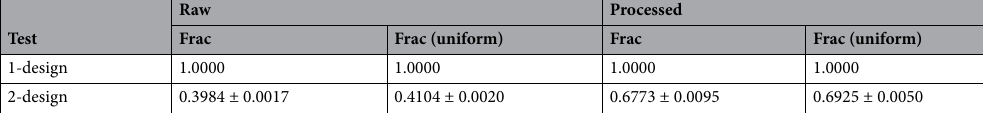
Table 8. Fraction of states for which the ensemble of unitaries generated using the ibmq_sydney quantum processor passed the different tests. ‘Raw’ shows the fractions without quantum readout error mitigation. ‘Processed’ shows the fractions with quantum readout error mitigation. The column with ‘uniform’ shows the fractions obtained when replacing the experimentally determined relative frequencies with uniform probabilities.